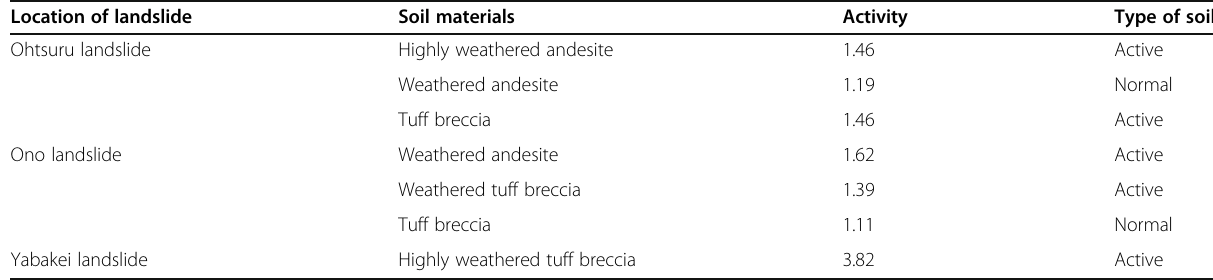
Table 2 Activity values in soil materials Location of landslide